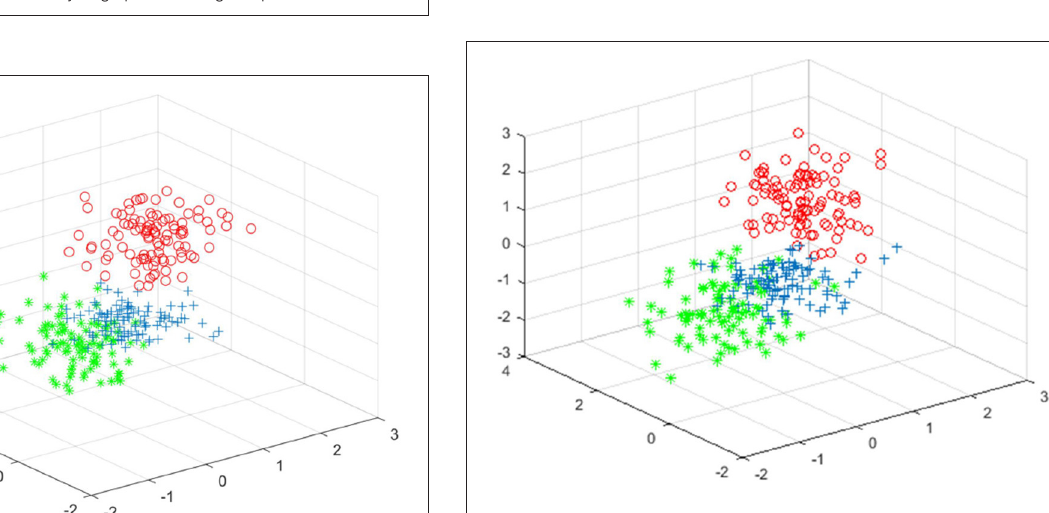
FIGURE 4 | Approximation analysis graph of missing sample attributes.